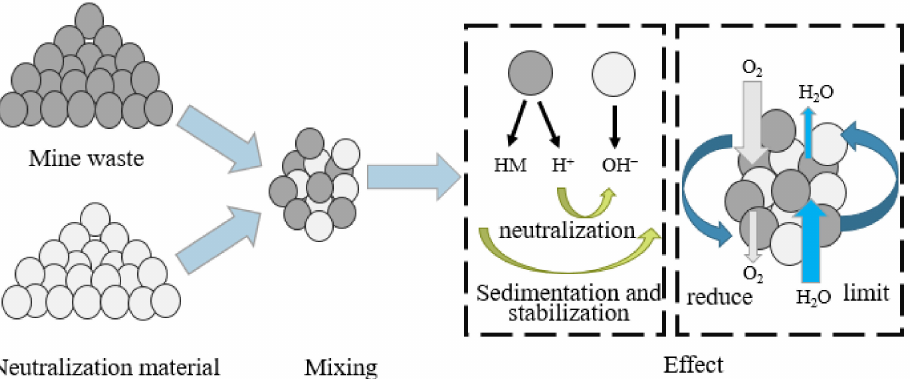
Figure 5. Mixing of mine waste and neutralizing materials [54]. This picture was adapted from [54] with permission from publisher Elsevier in March